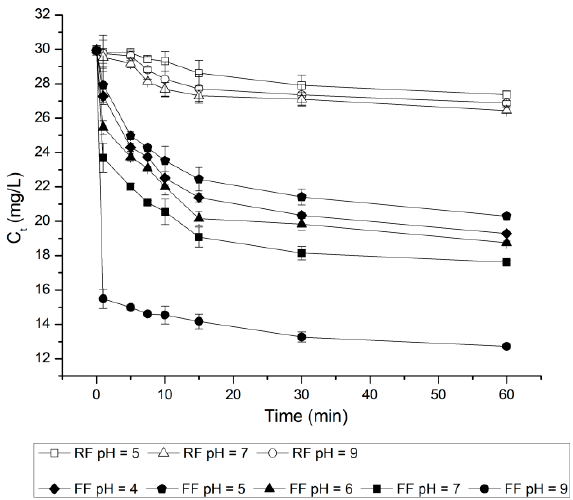
Figure 1. Effect of pH on the removal of Bisphenol A (BPA) by raw (RF) and functionalized (FF) fiber. Experimental conditions: fiber loading = 1 g; water volume = 100 mL; C 0 = 30 mg/L; water matrix = UP.